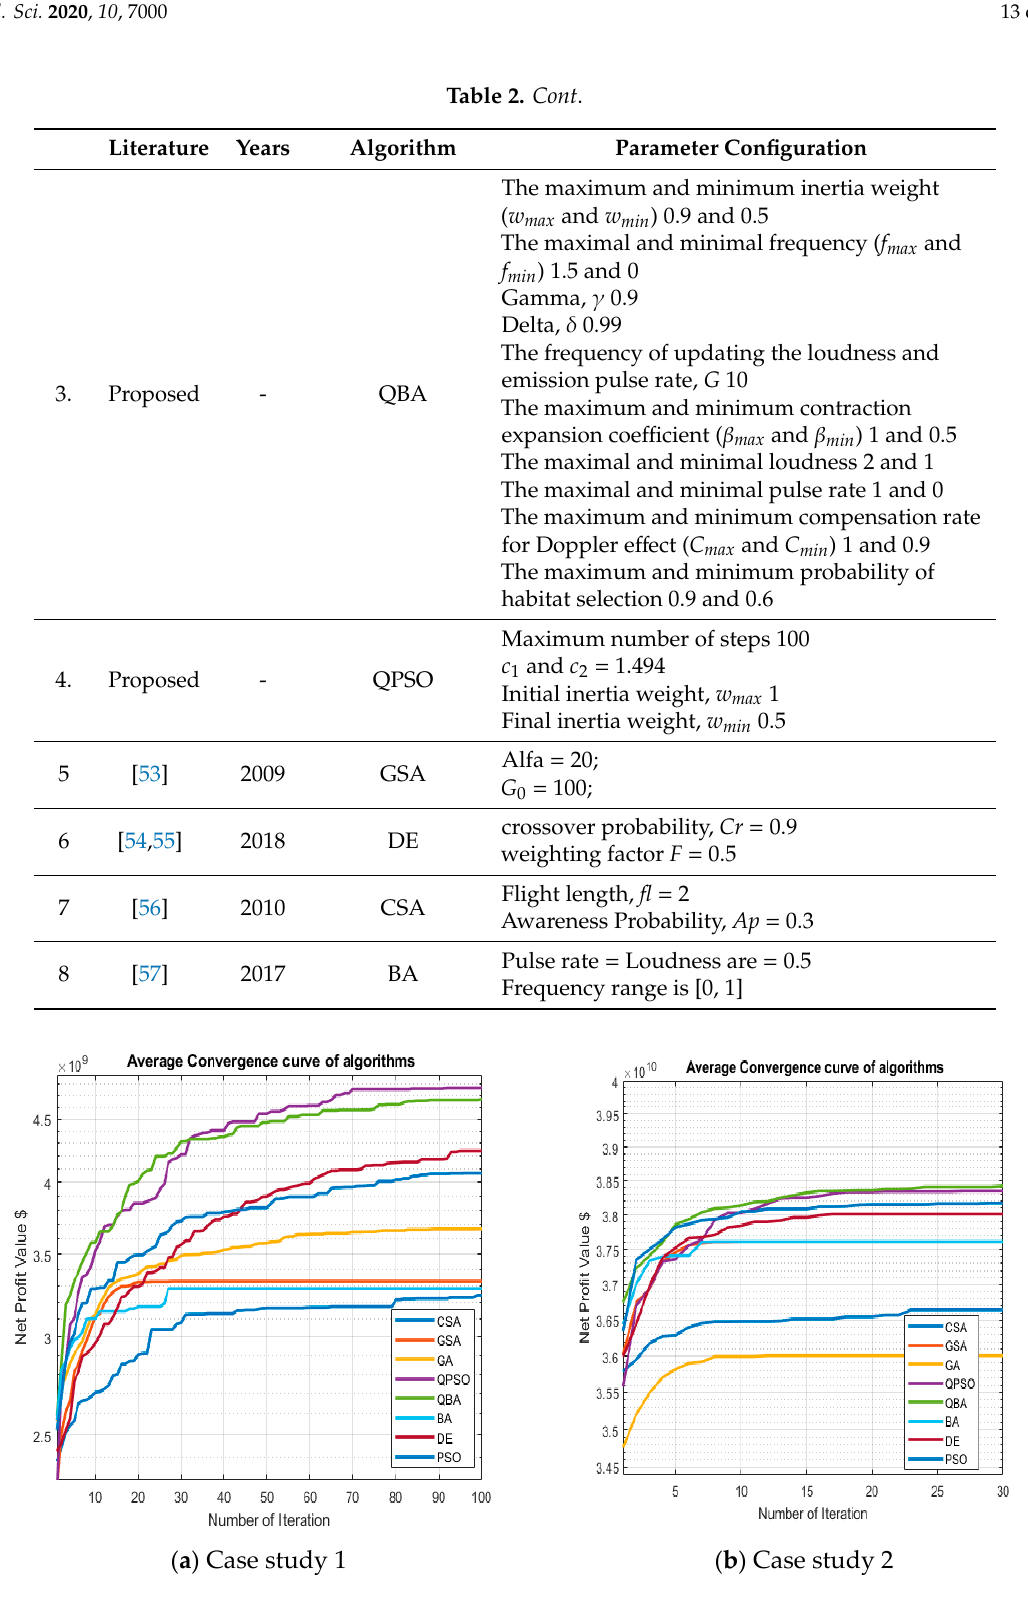
Figure 6. Convergence curve for PSO, crow search algorithm (CSA), gravitational search algorithm (GSA), and Niching CSA (NCSA) for case study 1 and 2.